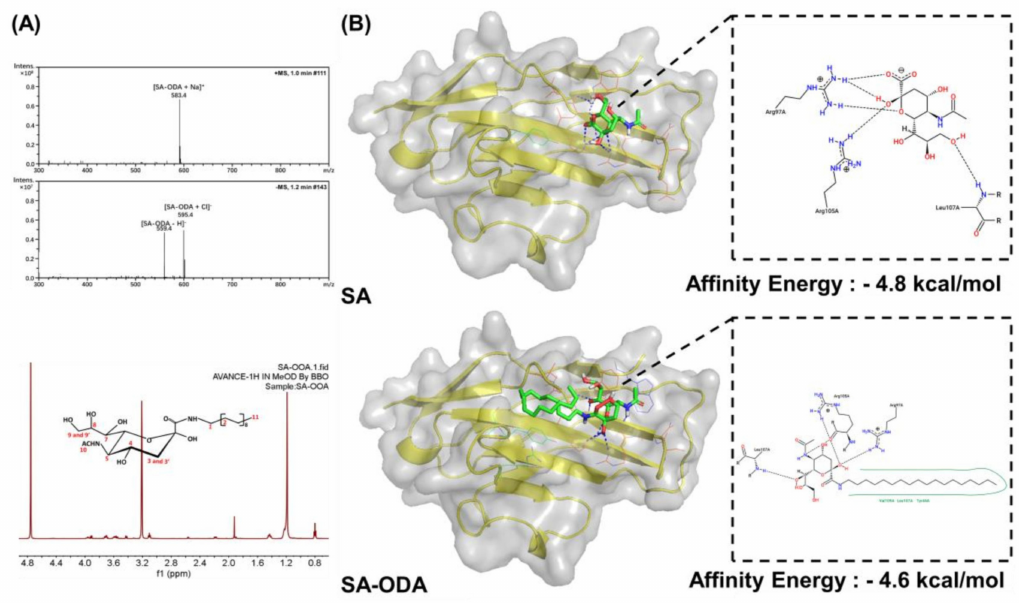
Figure 1. ( A ) Mass spectrum of the SA-ODA, and 1H NMR spectrum and chemical structure of the SA-ODA. SA-ODA, sialic acid-octadecylamine derivatives. ( B ) The specific recognition of Siglec-1 receptor and SA-ODA.